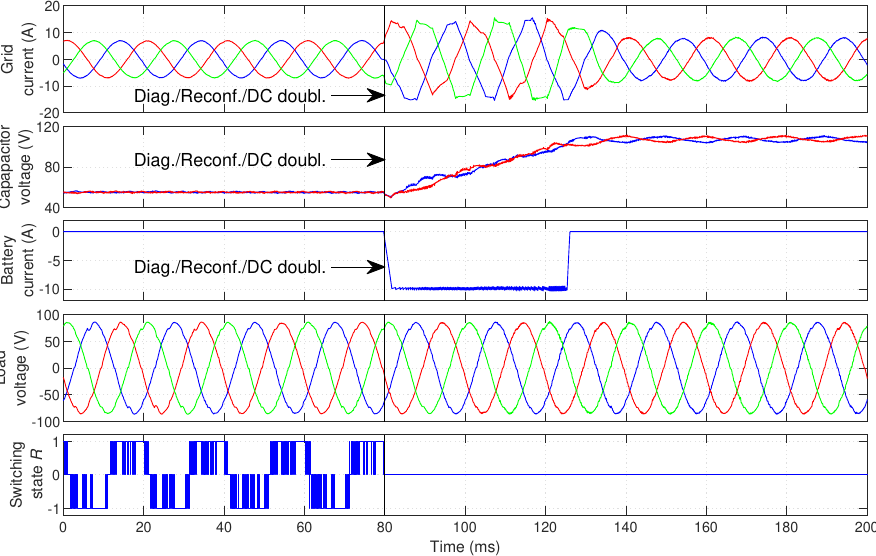
Figure 13. Normal and fault-tolerant UPS operation when an OC occurs in inner IGBT S R 2 of the GSC. An OC fault is created in IGBT S R 2 at t = 80 ms and is quickly identified. After the diagnosis, the reconfiguration is immediately performed and the DC bus voltage reference is doubled to 220 V. As seen in Figure 13, the switching state 0 is permanently selected in phase R after the reconfiguration. As soon as the fault is detected, the GSC and